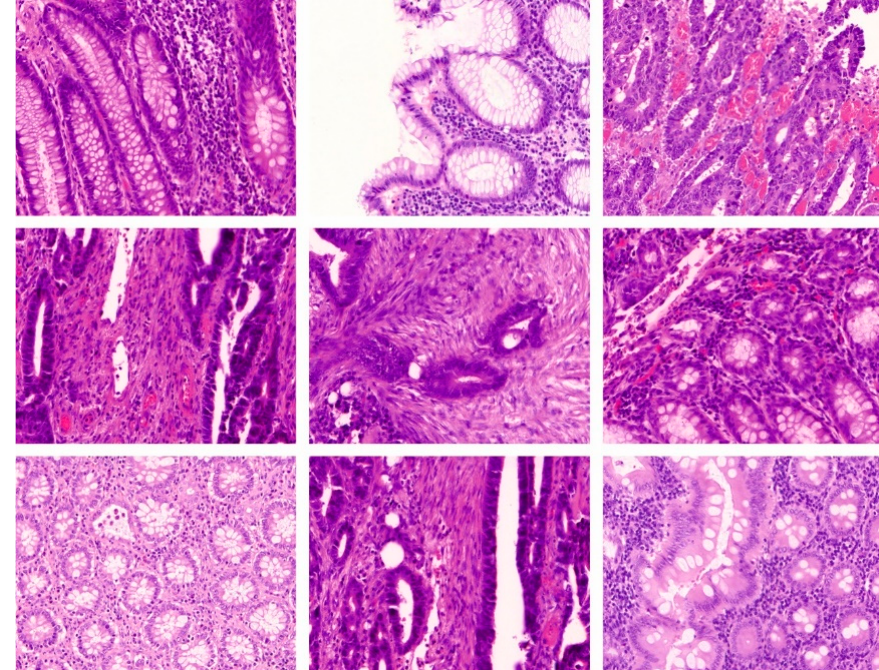
Figure 4. Sample Images of Colorectal Cancer.